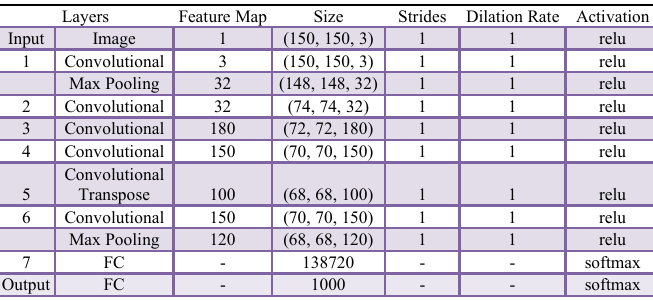
Figure 2 : The architecture of the ML neural network used to diagnose pneumonia from X-rays images . Table 1: Description of the structure of the neural network